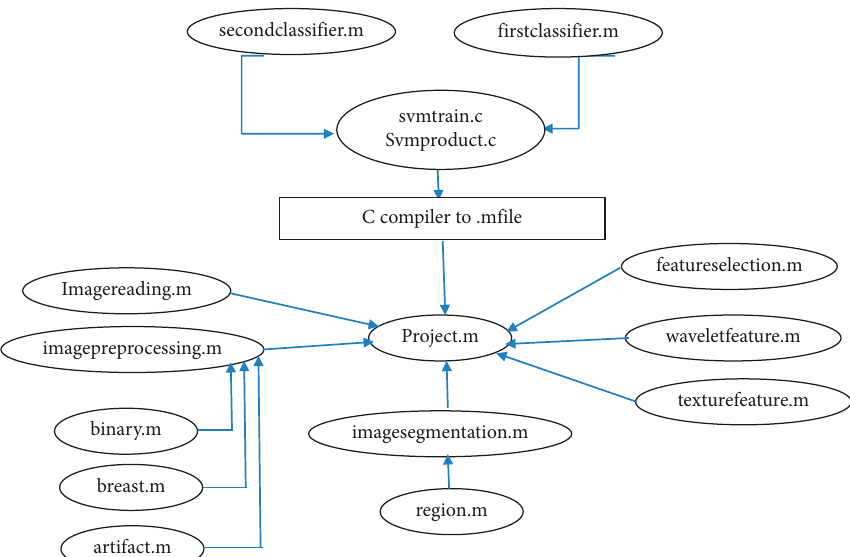
Figure 14: The relation between different MATLAB files used in the development of the proposed CADD system